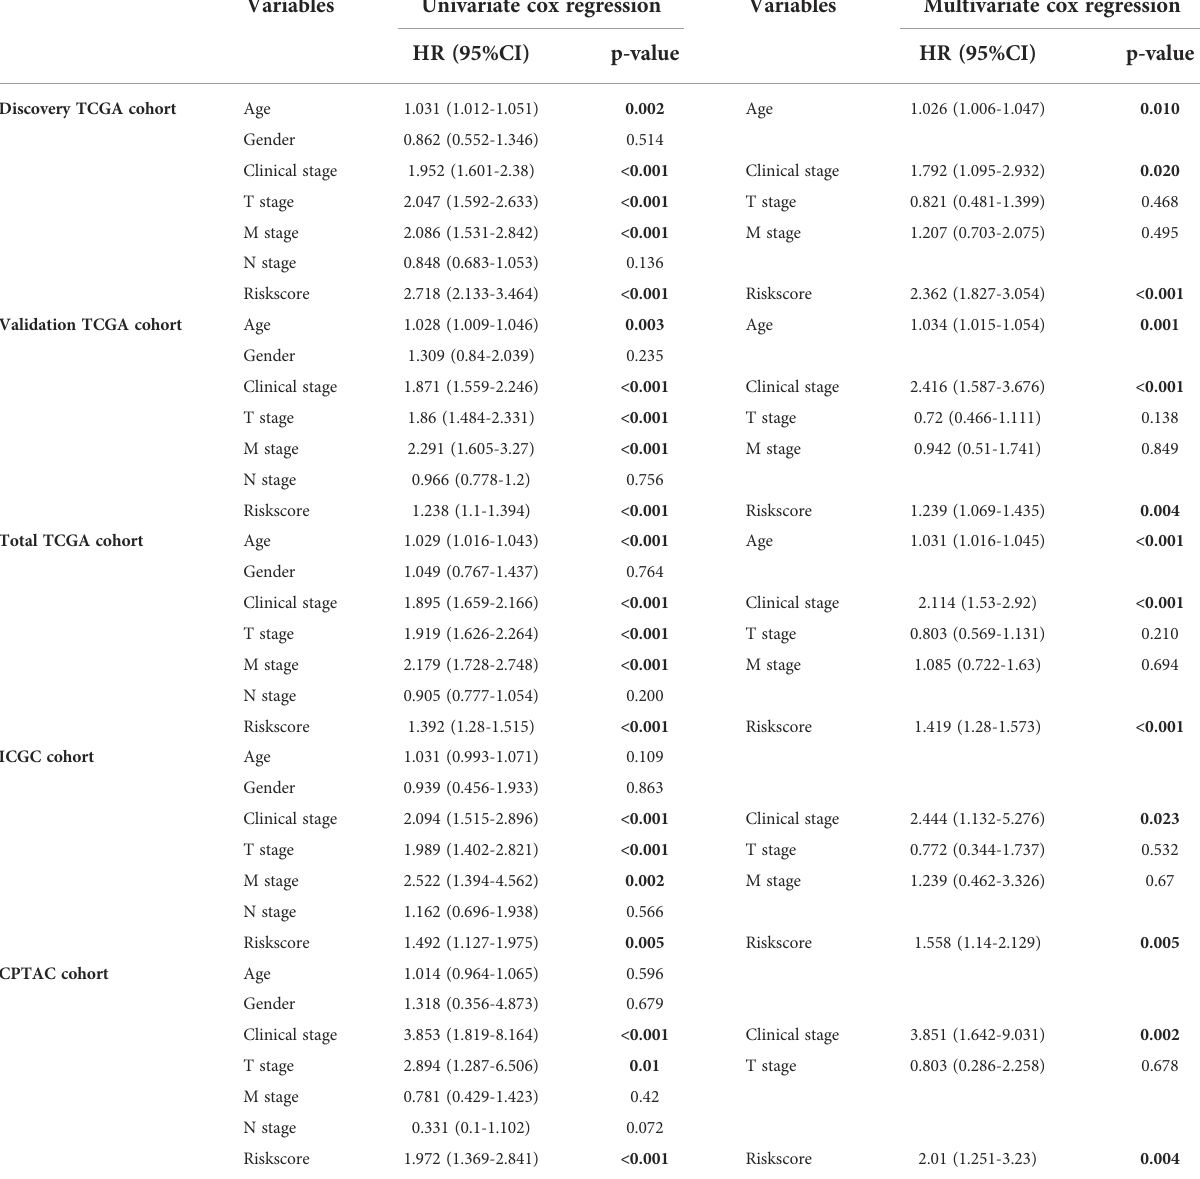
TABLE 2 Univariate and Multivariate Cox regression reveals TRGs risk score is an independent risk factor in kidney